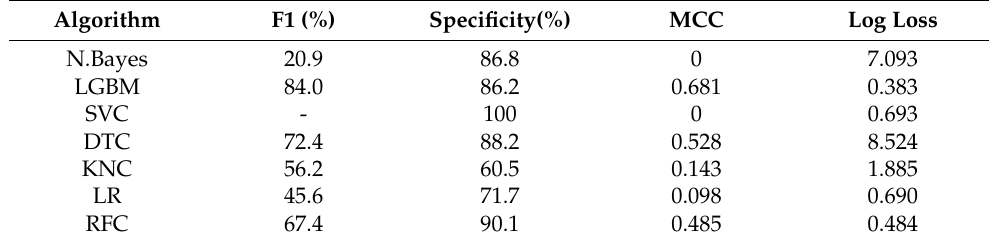
Figure 10. The obtained ROC curves with seven different classification algorithms using the first 13 channels of EEG signals. Table 7. The obtained other performance metrics results using the first 13 channels EEG signals with machine learning classification algorithms.